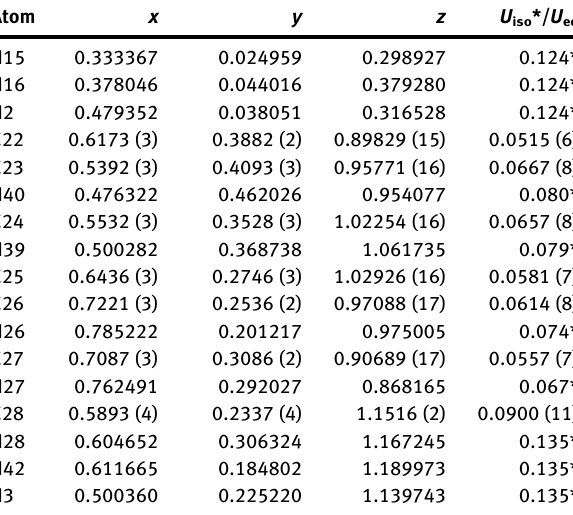
Table  : Fractional atomic coordinates and isotropic or equivalent isotropic displacement parameters (Å 